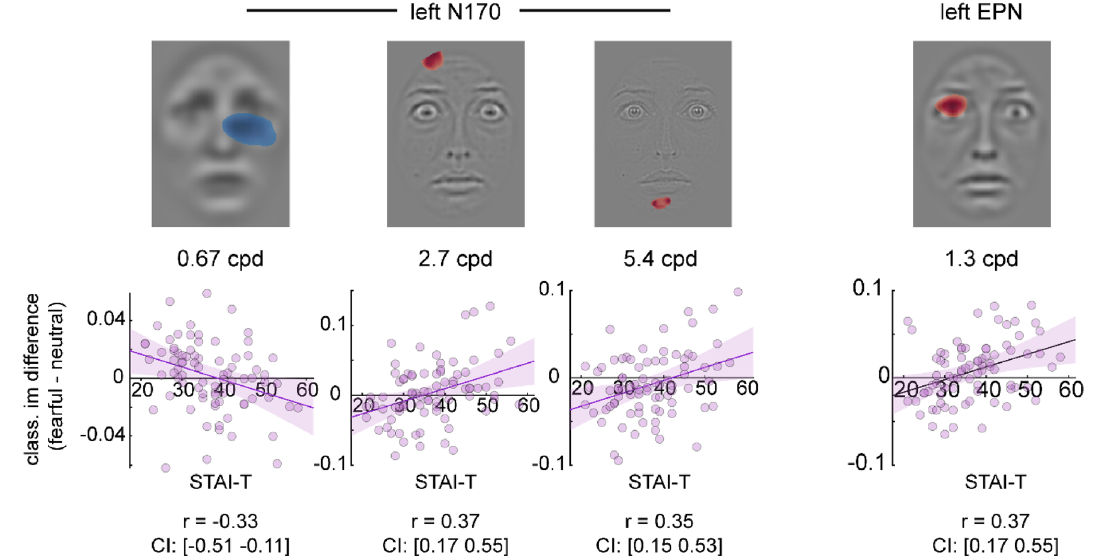
Figure 9. Results for cluster-based permutation analysis of correlations between trait anxiety scores and classification maps. Please note that none of the depicted clusters cross the significance threshold of cluster-α = .01. They are merely presented for completeness and future exploration. The bottom row shows scatterplots of individual trait anxiety scores plotted against the individual classification image differences (fearful–neutral) at the peak pixel of the depicted cluster. The Pearson correlation coefficient r and its confidence interval (CI) is noted below each scatterplot. Dark purple lines are linear regression lines displayed with a 95%